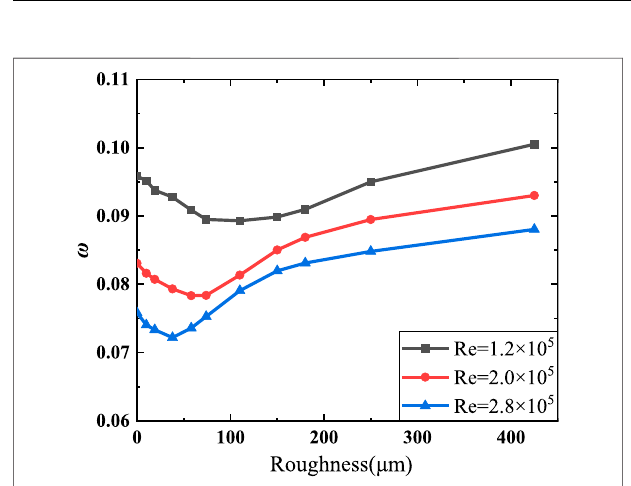
Frontiers in Energy Research |